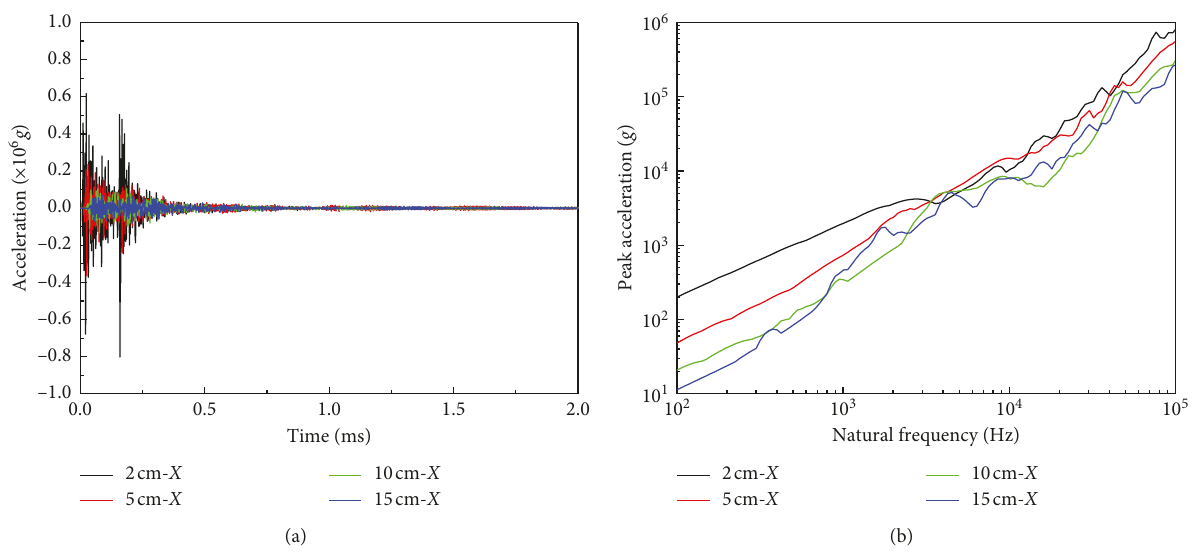
Figure 28: Separation shock in the X direction at four different locations. (a) Acceleration history. (b) SRS.